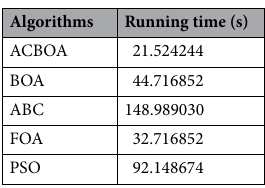
Table 5. Algorithm running